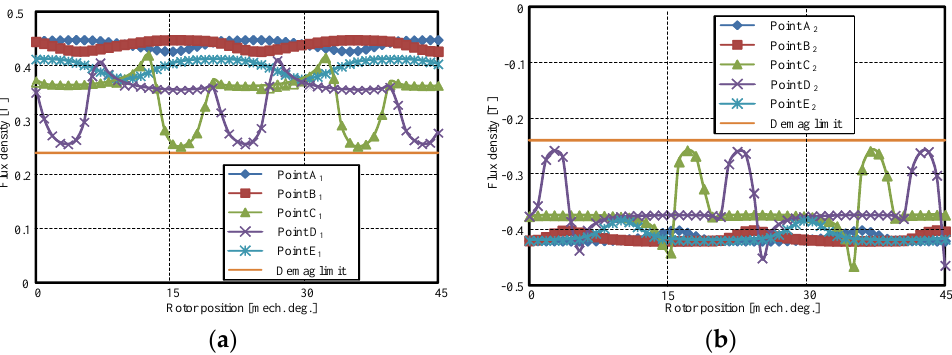
Figure 12. Flux densities (radial direction) of different locations of the magnets: ( a ) Points of the inner magnet; ( b ) Points of the outer magnet.